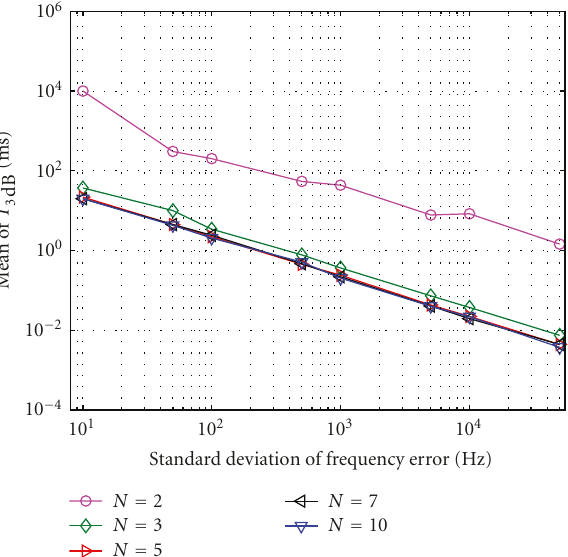
Figure 5: Relation between received power and the number of nodes under di ff erent phase errors. Figure 6: Relation between T 3dB and frequency synchronization error with di ff erent number of